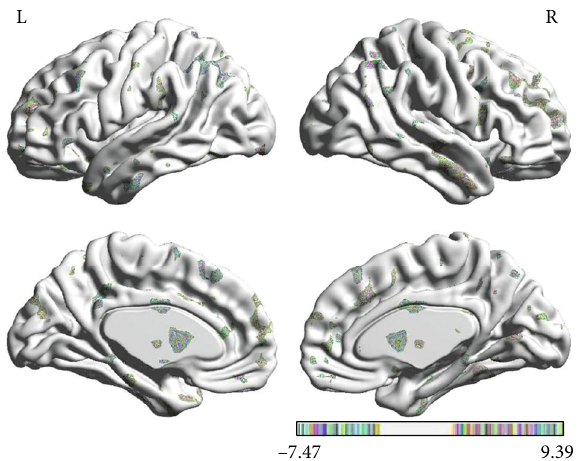
Figure 10: Regions showing signi fi cantly di ff erent EC with the rACC in nocebo status compared with pain status (EG). Table 7: Locations of the regions showing signi fi cantly altered EC with the rACC in IG compared with EG in nocebo status ( p < 0 : 05 , FDR < 0 : 05 ).